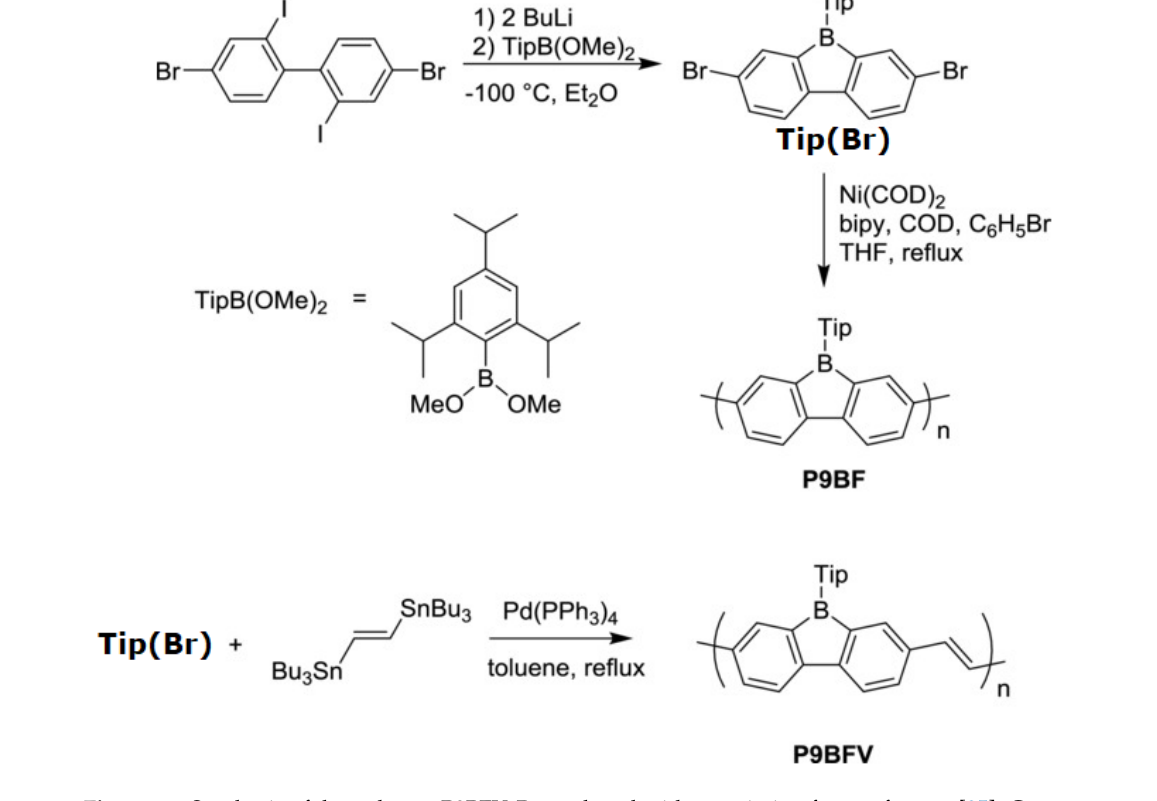
Figure 11. Synthesis of the polymer P9BFV. Reproduced with permission from reference [95]. Copyright 2015, John Wiley and Sons.